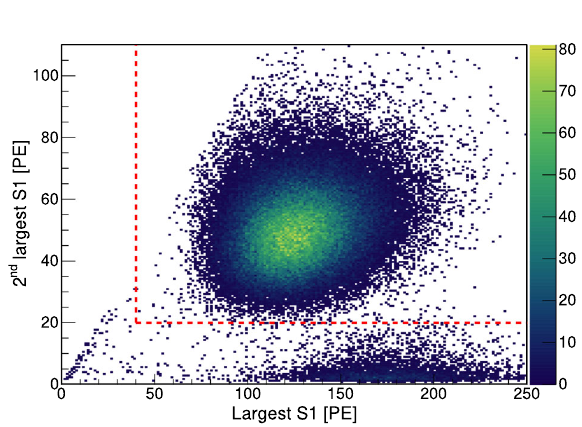
Fig. 11 Population of 83m Kr events and the selection (red lines) using the time coincidence of its 32.1keV and 9.4keV decay lines